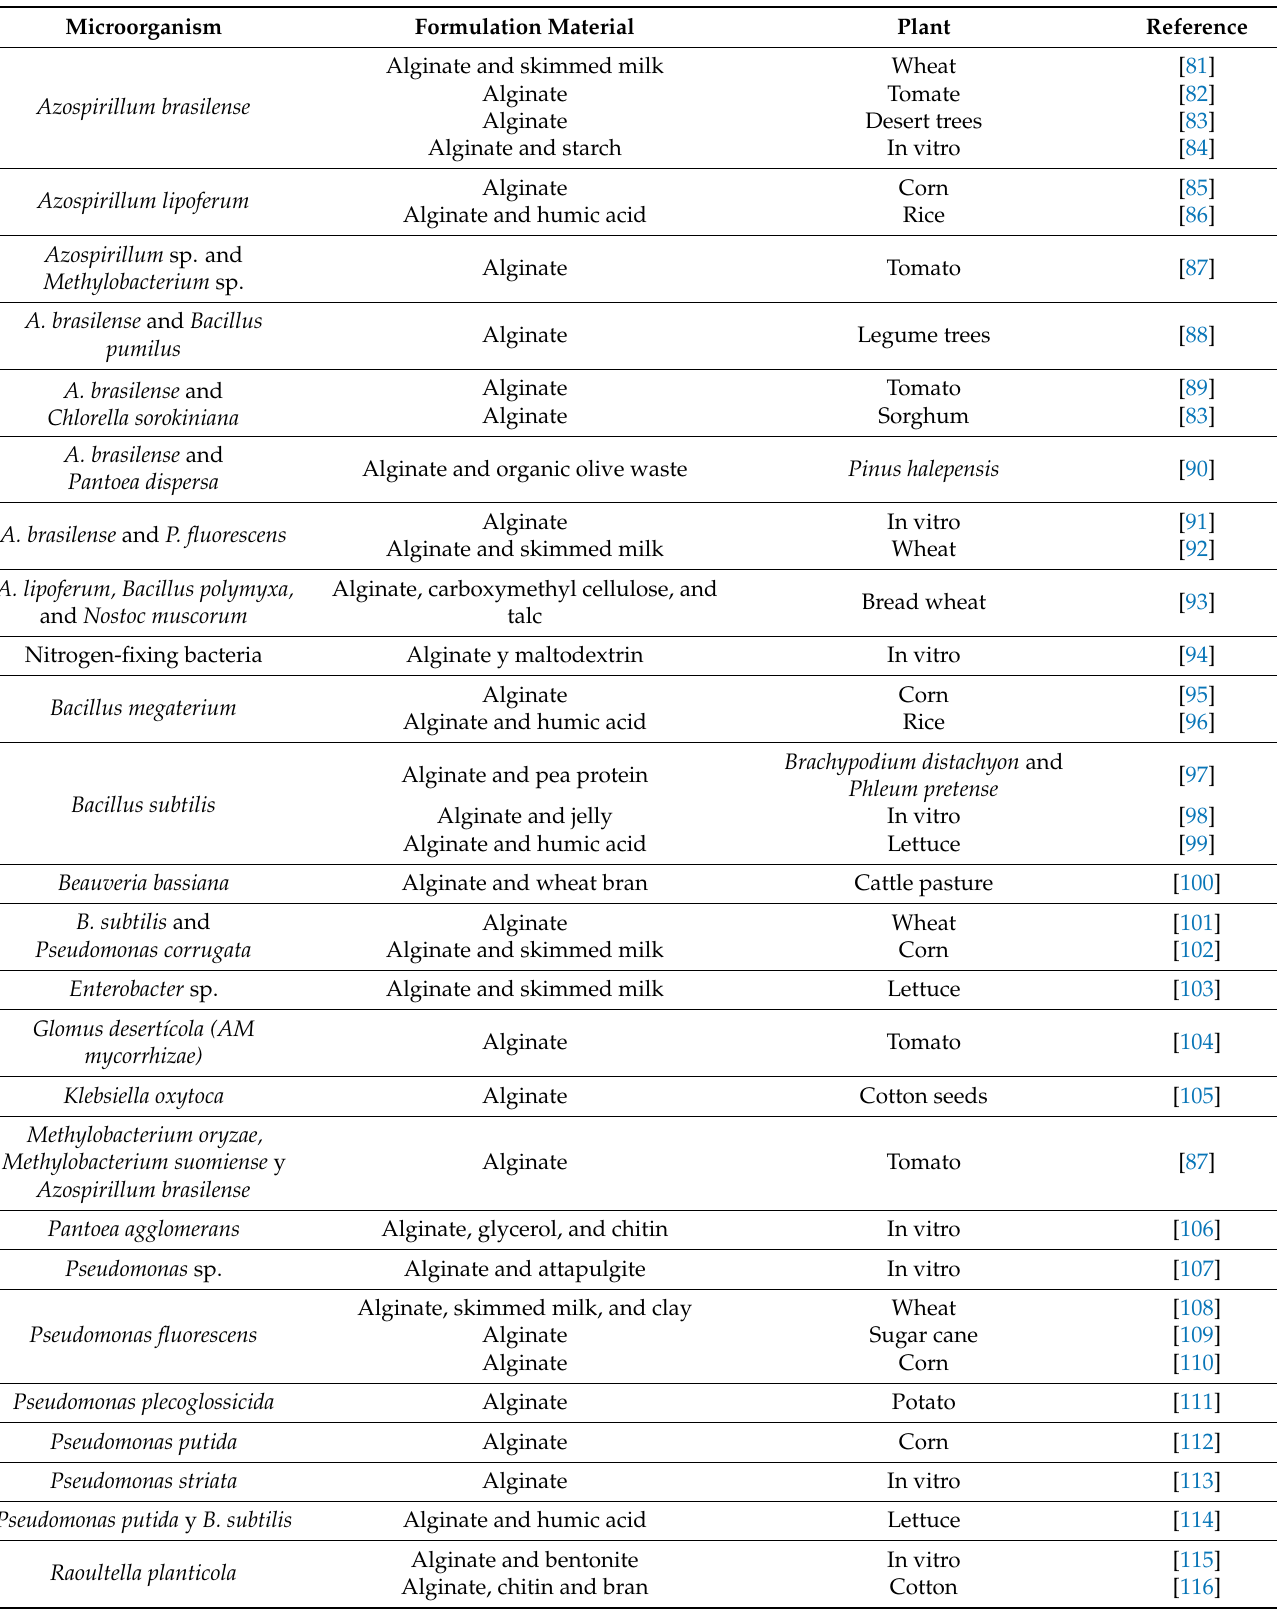
Table 2. Plant growth-promoting microorganisms encapsulated in alginate-based formulations to increase microbial viability and efficacy tested in different plants and